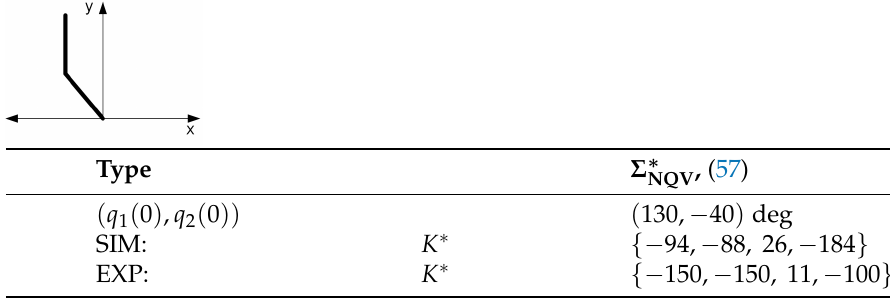
Table 9. Case B2: Initial posture of the Pendubot and parameters of the nonlinear